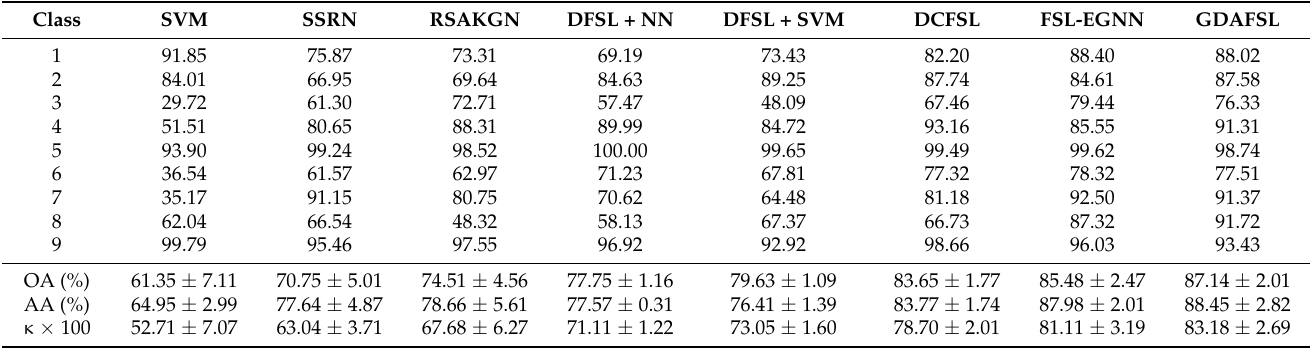
Table 8. Classification Results (%) of Various HSI Classification Methods on UP Dataset with 5 Labeled Samples Per